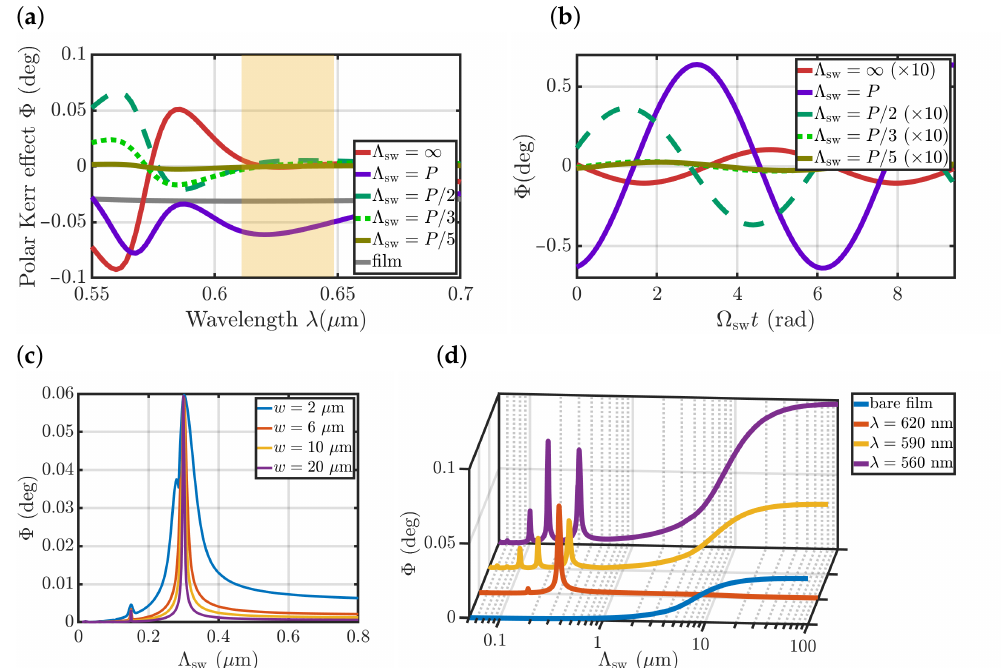
Figure 3. Magnetophotonic detection of the short spin waves. ( a ) Polar Kerr effect Φ spectra for different spin-wave wavelengths Λ sw (see legend). ( b ) Polar Kerr effect Φ dependence on the phase of the spin wave at λ = 620 nm. ( c ) Polar Kerr effect Φ dependence on the laser beam width w for λ = 620 nm. ( d ) Sensitivity of the polar Kerr effect Φ ( Λ sw ) measured at different wavelengths in the proposed metasurface and in the bare film (see the legend) by w = 6 µ m beam